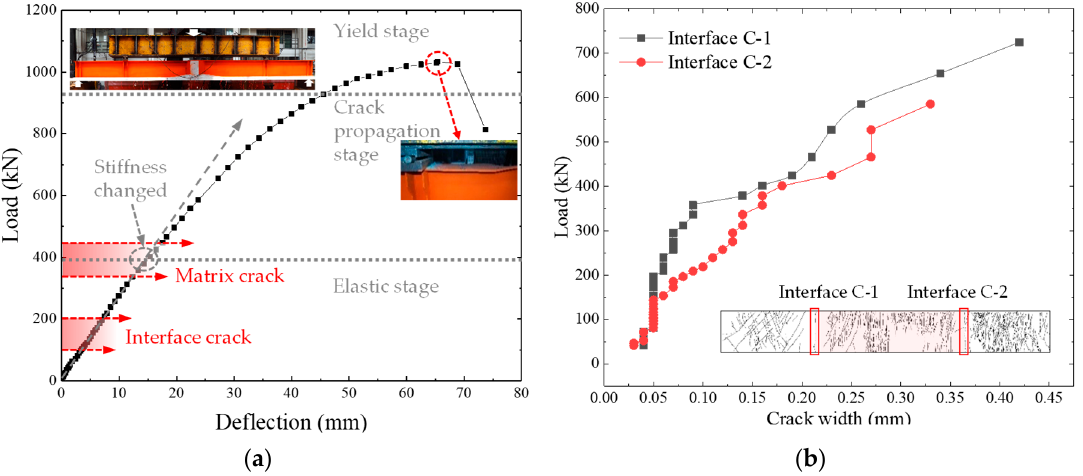
Figure 11. Test results: ( a ) load-deflection of mid-span; ( b ) load-crack width curve of joint interface.